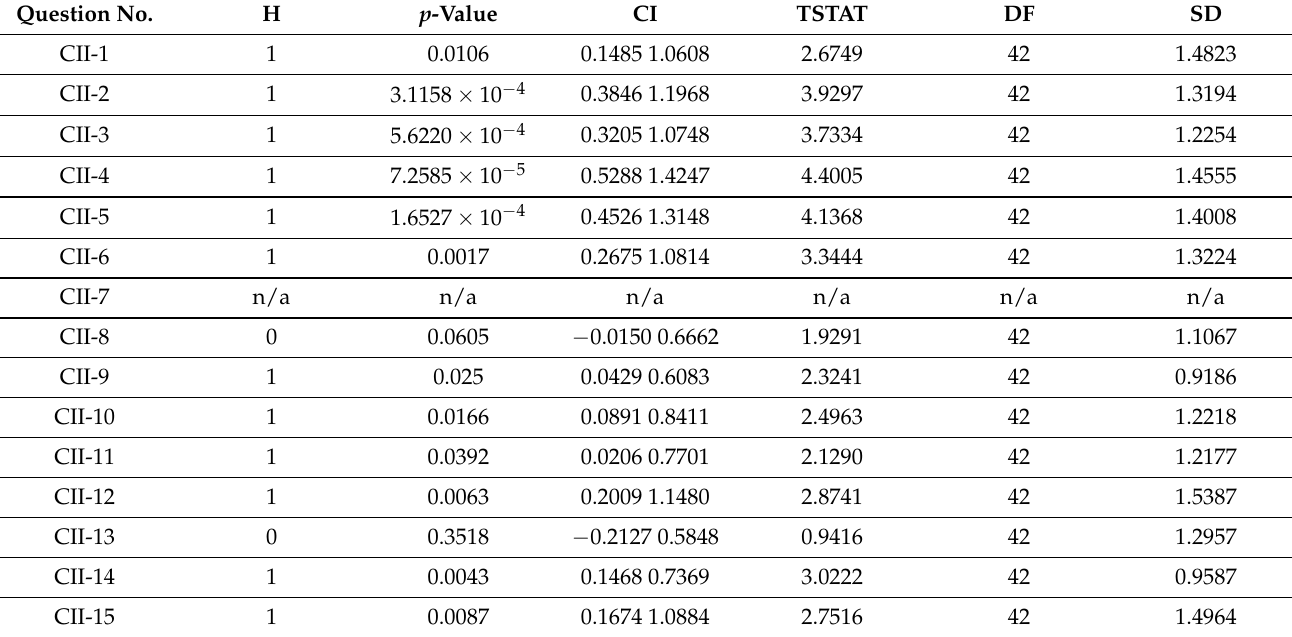
Table 7. The statistical t -test of CII-7 (CII-N43) against other questions.